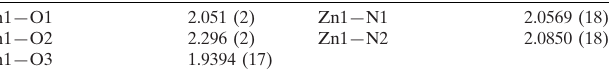
Selected bond lengths (A˚ ).